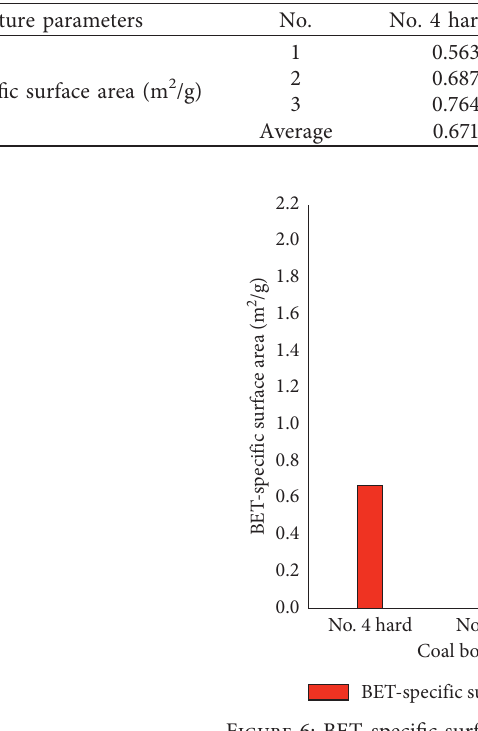
Table 3: BET-specific surface areas of the different coal seams.